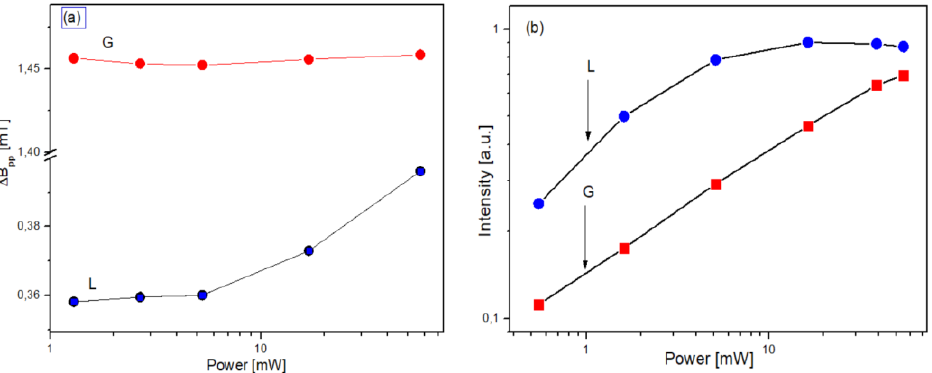
Figure 3. The parameters of EPR spectrum from Figure 2a as a function of microwave power: ( a )/ line widths of Gaussian and Lorentzian components ∆ B G , and ∆ B L ( b )/ A G and A L of Gaussian and Lorentzian components,